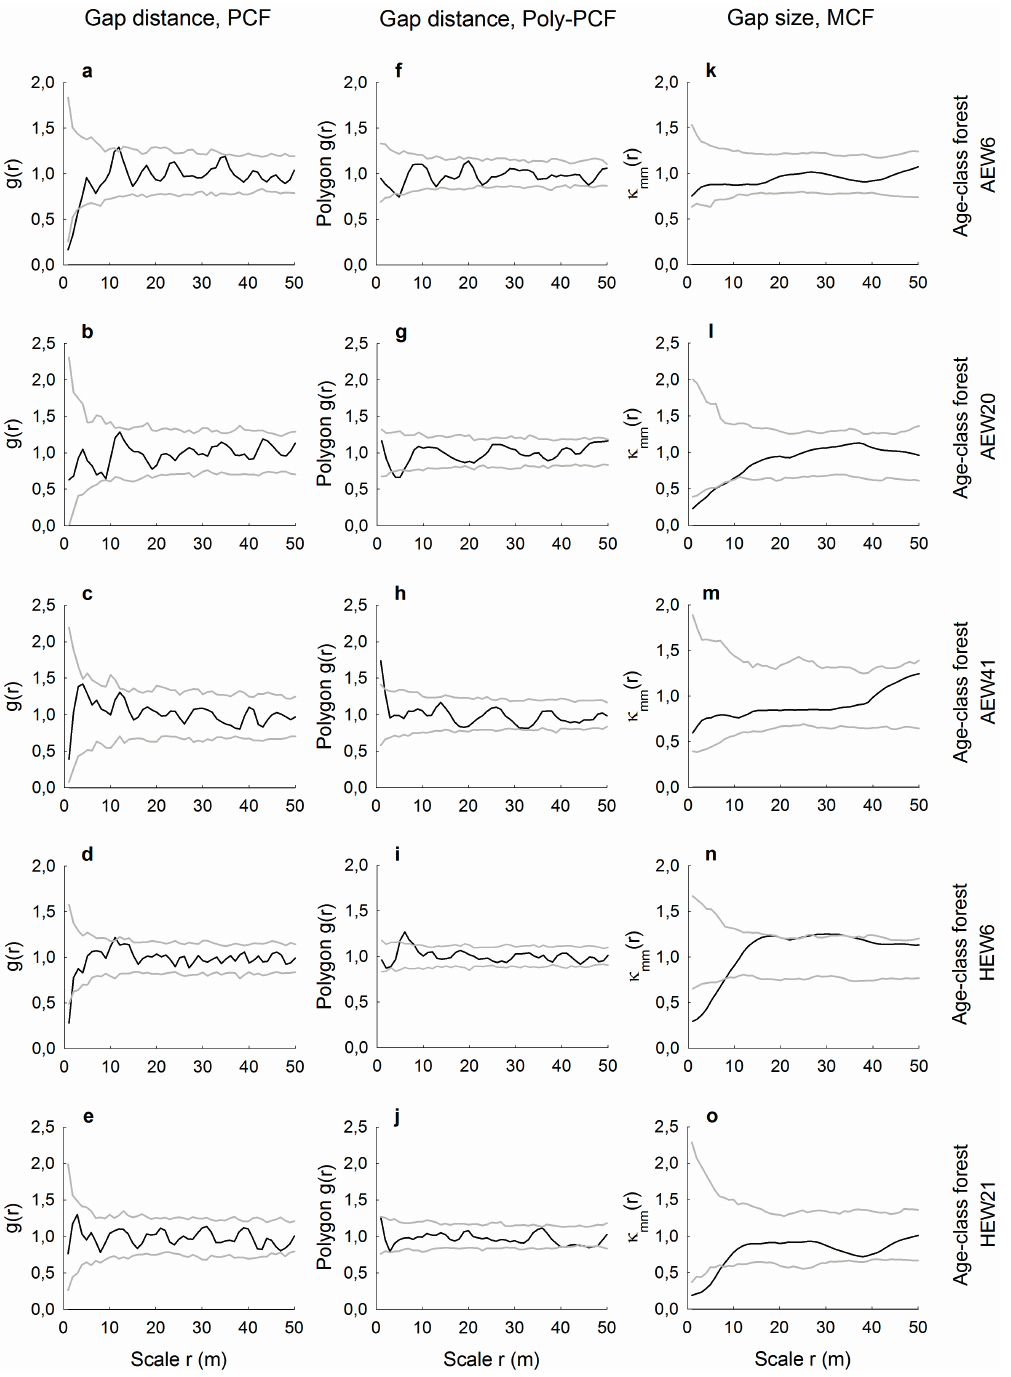
Figure 3. Spatially-explicit gap analyses of age-class forests (AEW: Schwäbische Alb; HEW: Hainich) with the conventional pair correlation function ( a – e ), the polygon-based pair correlation function (PCF) ( f – j ) and the mark correlation function ( k – o ). The grey envelopes of the complete spatial randomness (CSR) null model ( a – j ) and of the null model of random gap-size distributions ( k – o ) were obtained from the fifth-lowest and fifth-highest values taken from 199 Monte Carlo simulations. If the black line is below or above the null model, gaps were, at neighborhood radius r , regularly spaced or aggregated, respectively ( a – j ), or gap sizes were negatively or positively correlated, respectively ( k – o ). MCF, mark correlation